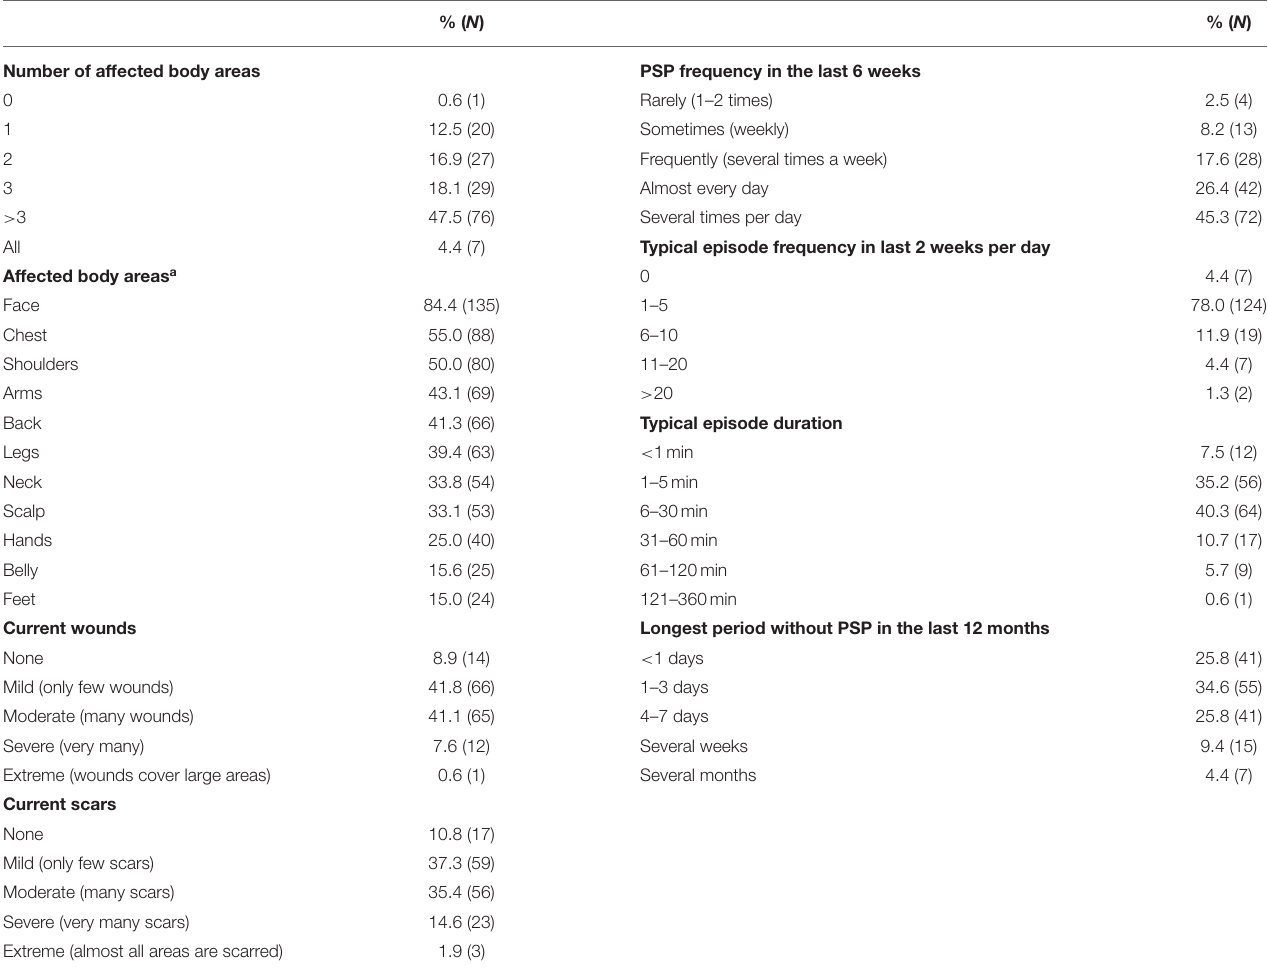
TABLE 2 | Skin picking